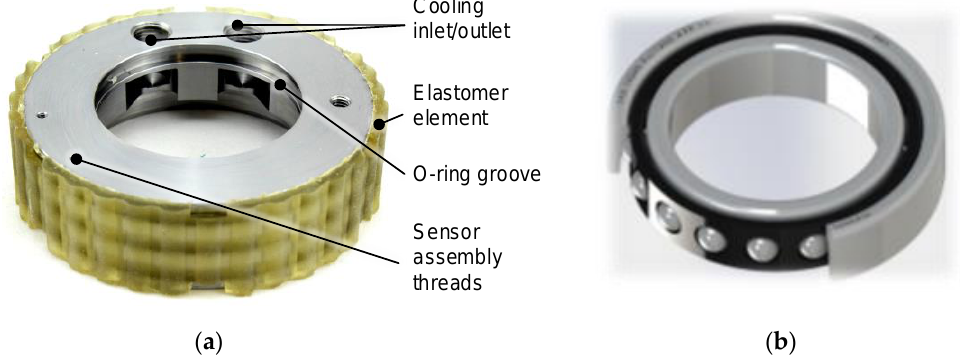
Figure 24. ( a ) Part of the bearing shield; ( b ) hybrid spindle bearing myonic SRD 30550VA with a bore diameter of 30 mm and a contact angle of 15° used in the developed bearing system.